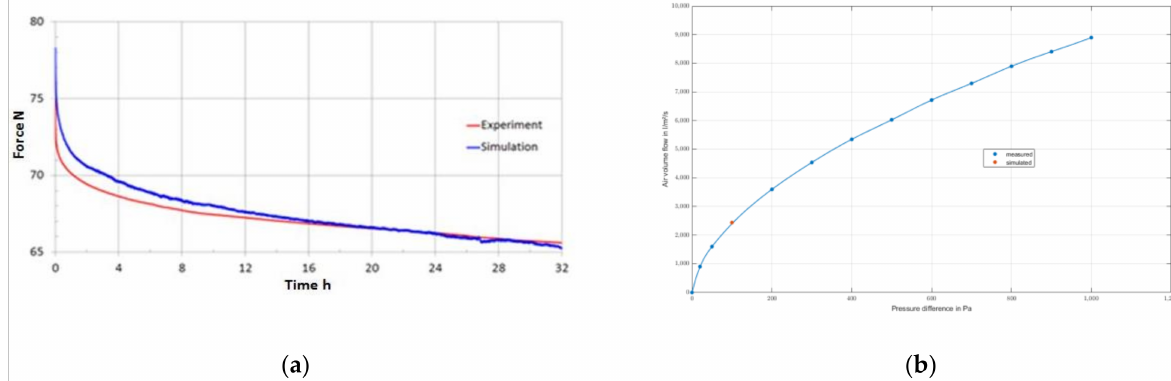
Figure 14. ( a ) Compression of spacer fabric with relaxation over 32 h, comparison of experiment and the simulation; ( b ) air volume flow per area as a function of pressure difference through a spacer fabric. Measured values and simulation for pressure difference 100 Pa.